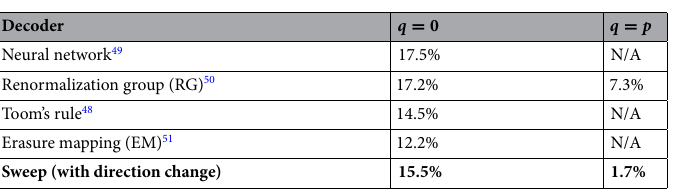
Table 1. Comparison of the error thresholds of (cubic) toric code decoders against phase-flip noise with ( q = p ) and without ( q = 0 ) measurement errors. Our results are shown in bold.